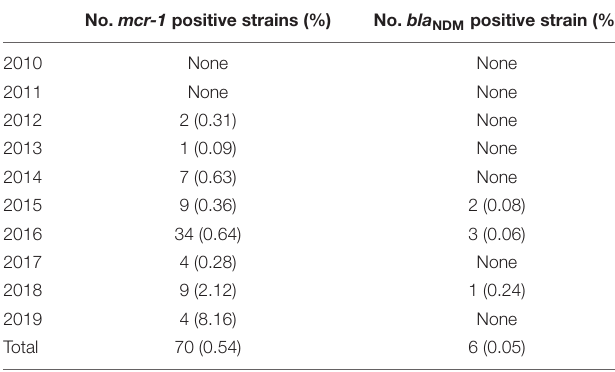
TABLE 3 | The positive rate of strains with mcr-1 or bla NDM isolated from different sources.